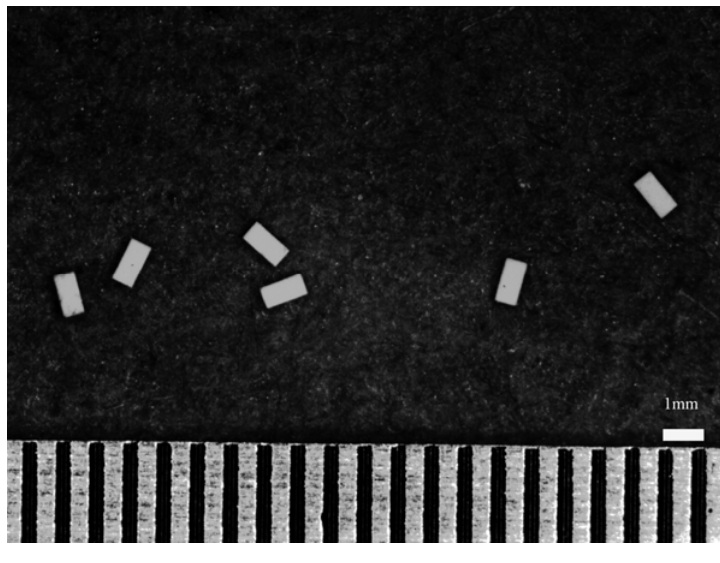
Figure 1. Morphology of the platelets used in the present